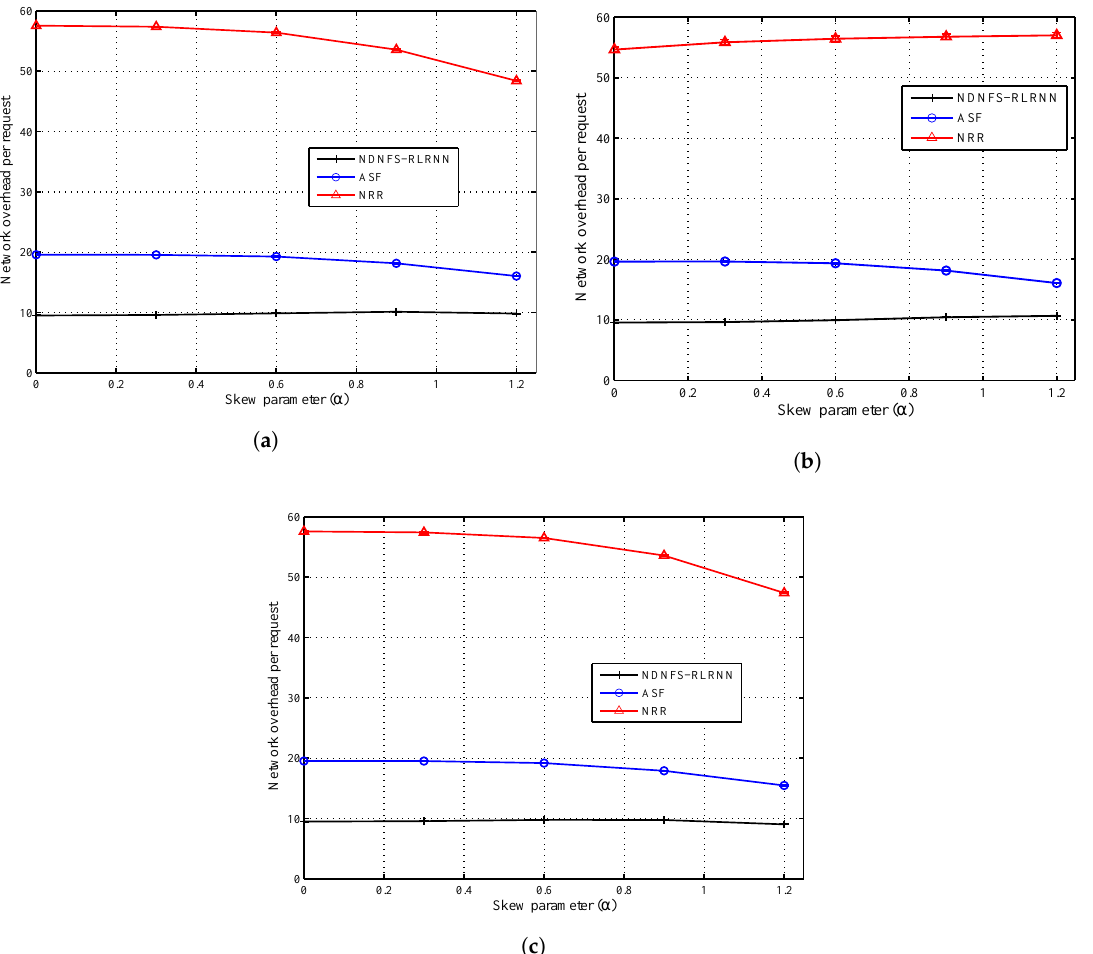
Figure 7. Network load performance of NDNFS-RLRNN ( p = 0.3), ASF and NRR for